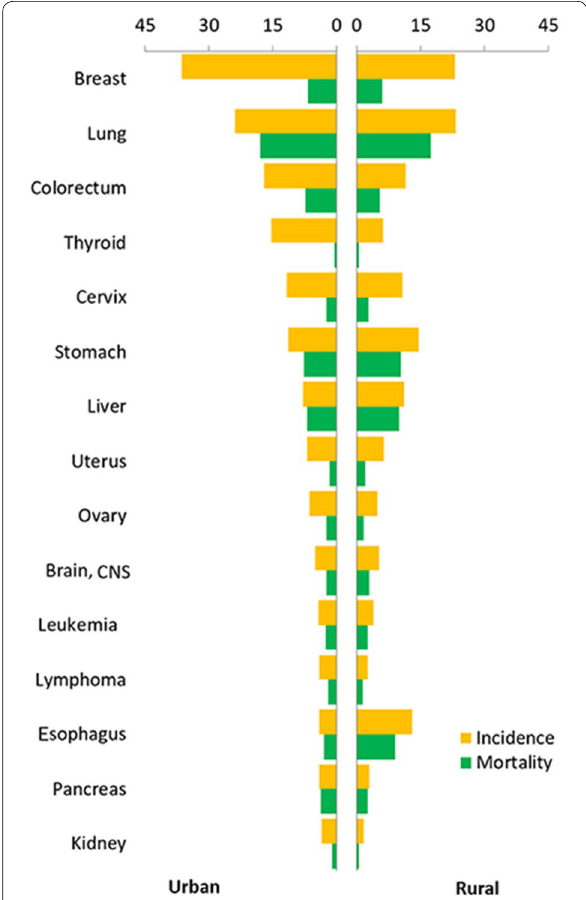
Fig. 2 Cancer incidence and mortality in urban and rural areas for females in China in 2012 (1/100,000). CNS central nervous system